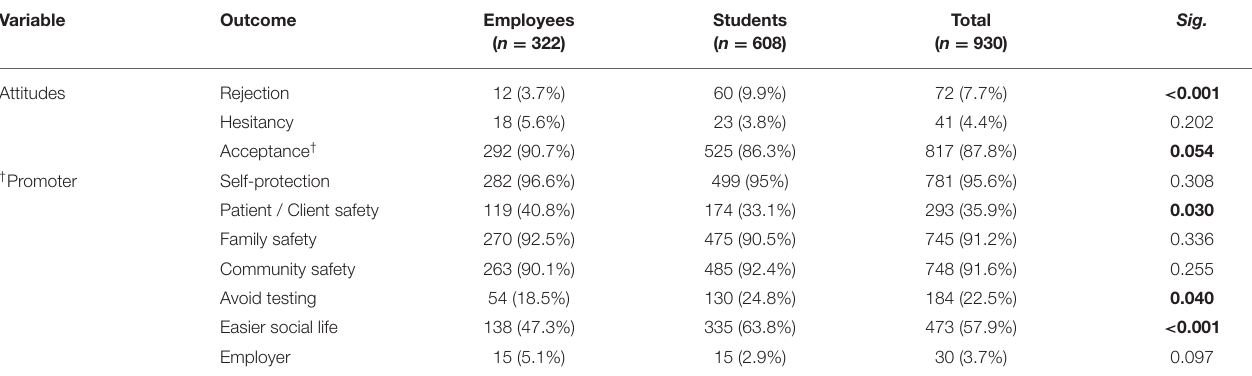
TABLE 3 | COVID-19 Vaccine-related attitudes of German university students and employees participating in the COVID-19 Vaccine Booster Hesitancy (VBH) Survey, december 2021 ( n = 930).